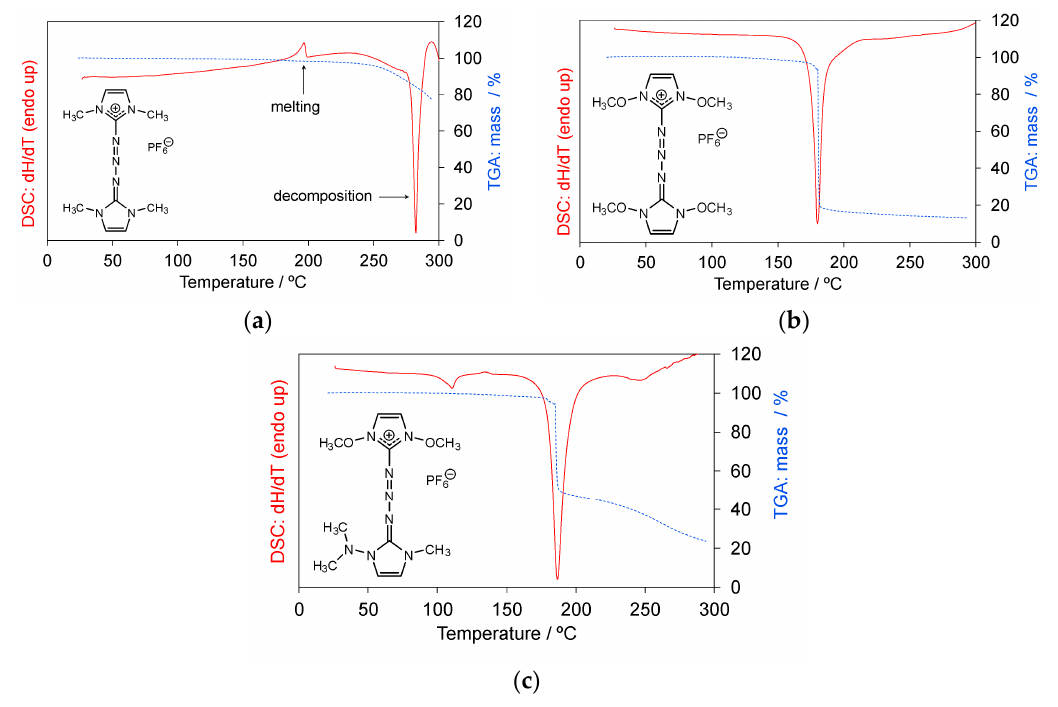
Figure 6. ( a – c ) DSC and TGA of the triazenes 1 – 3 .